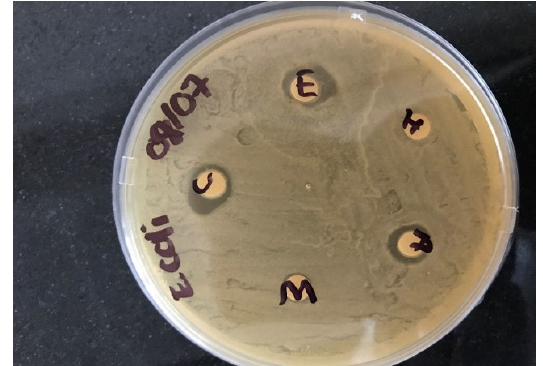
Figure 2. Antimicrobial activities of sunflower seed extracts on different solvents. Source: Researcher (2020).